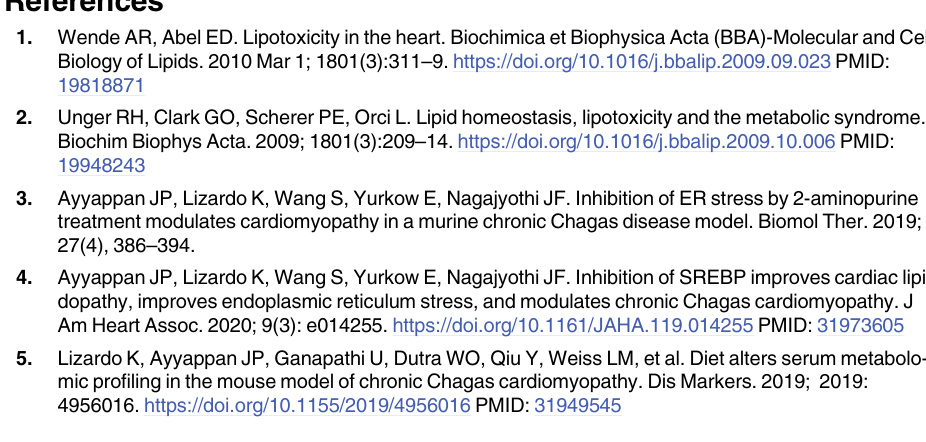
S3 Fig. Effect of fat ablation on parasite persistence, cardiac morphology and functioning in chronic CD murine model (90DPI). A. Assessment of the parasite load by quantitative PCR in adipose tissue of infected (Inf) and infected fat-ablated (Inf+FAB) mice, � P � 0.05. B. Assessment of the parasite load by quantitative PCR in the hearts of infected (Inf) and infected fat-ablated (Inf+FAB) mice, � P � 0.05. C. Hematoxylin and eosin (H&E) and masson trichrome staining of hearts in indicated mice (infected or uninfected mice, fat-ablated (Fab+) or fat- unablated (Fab-). Presence of lipid macro-lipid droplets (black arrow) and micro-lipid gran- ules (black arrowhead). Bar = 100 μ m, 20x magnification. D. Change in ejection fraction (EF) and fractional shortening (FS) analyzed by cardiac imaging. �� p � 0.01 compared with unin- fected